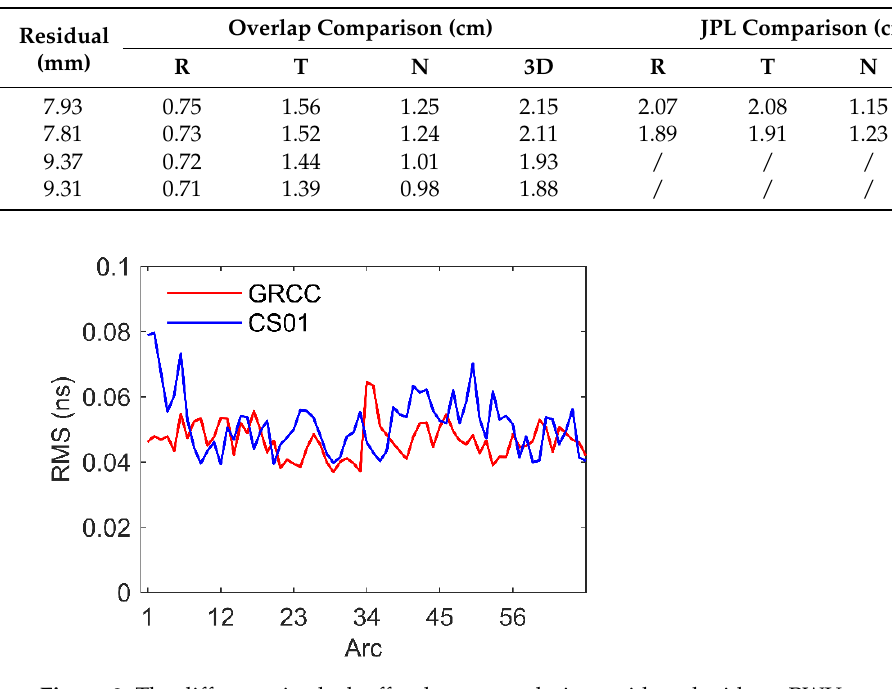
Figure 8. RMS of orbital differences for GRCC and CS01 with/without PWU corrections. Table 3. The RMS of residual and orbital comparison with/without PWU for GRCC and CS01.